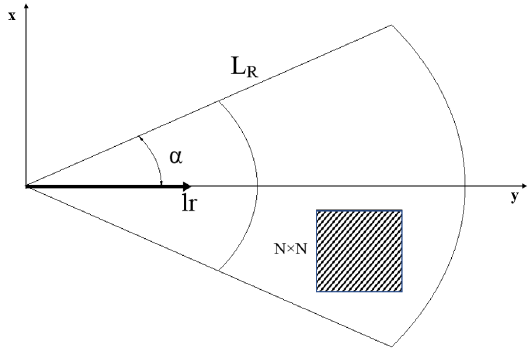
Figure 5. Parameters of sector searching area.